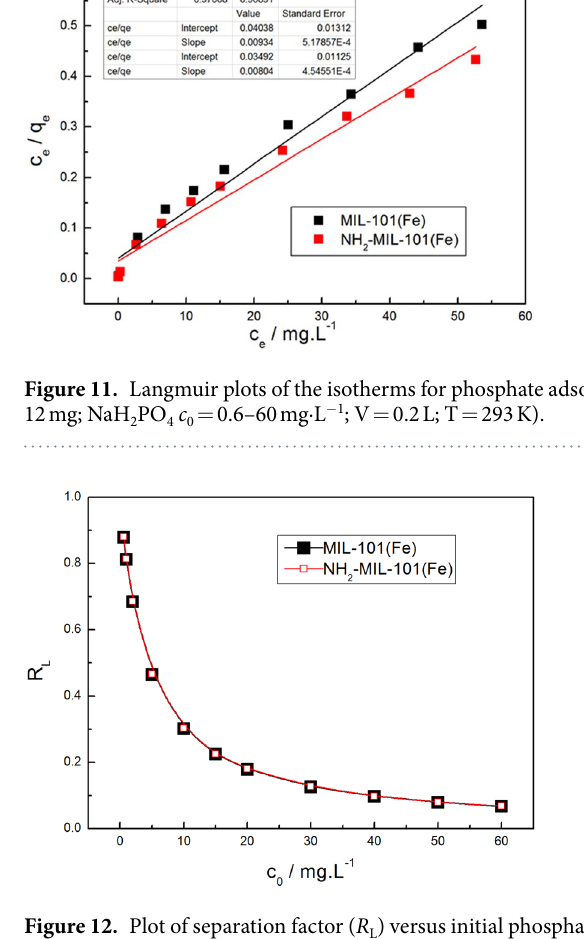
Figure 12. Plot of separation factor ( R L ) versus initial phosphate concentration( c 0 ) ( Adsorbents, 12 mg; NaH